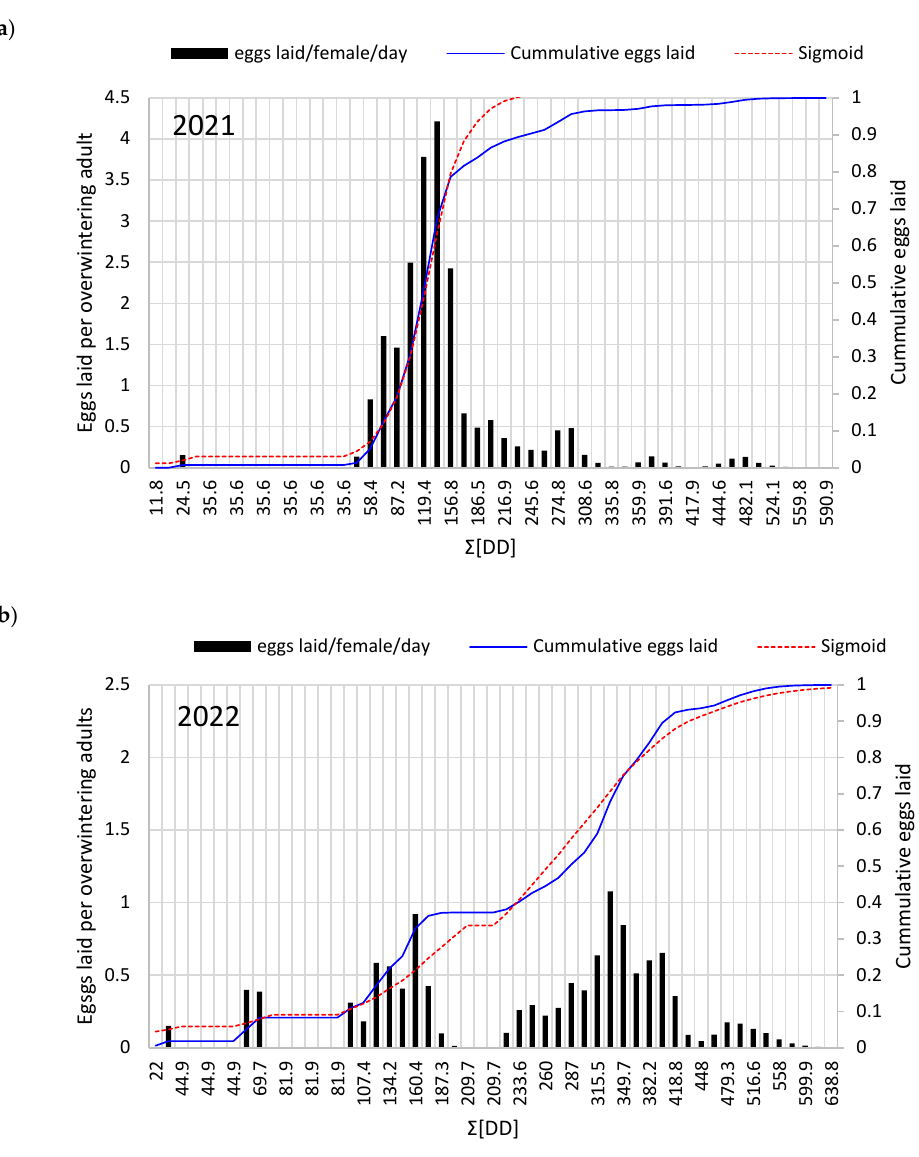
Figure 3. Simulated T. urticae egg production model output and related during the dry bean growth season of ( a ) 2021 and ( b ) 2022 in the region Prespa lakes in Northern Greece. The predicted physiological age of total spider mite immature development (i.e., egg to adult of the succeeding generations) for the growth season of 2021 and 2022 is depicted in Figure 4a,b, respectively. According to the physiological rate model, T. urticae com- pleted eight to nine generations from early May until late August (Figure 4). It is worth noting that the first noticeable bean damage (~10%) was observed after the prediction of